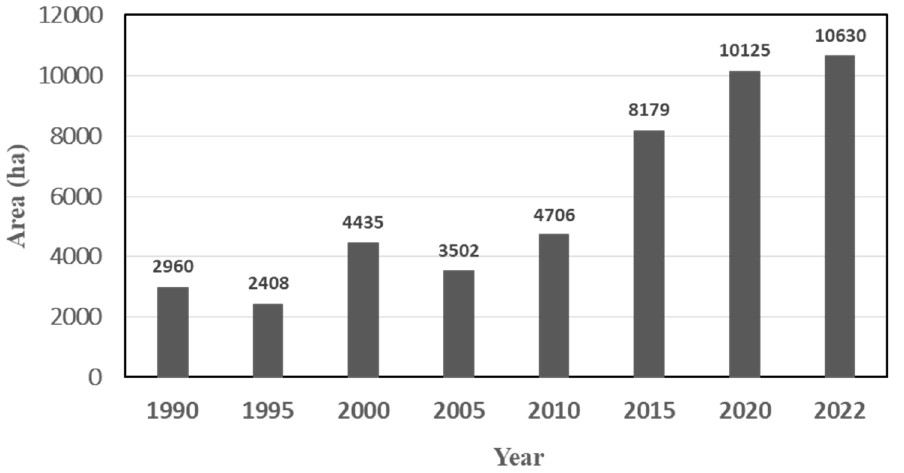
Figure 4. The estimated mangrove area in the RRD from 1990 to 2022. Table 2. The confusion matrix for accuracy assessment of mangrove forest using Landsat 8-OLI in 2020.